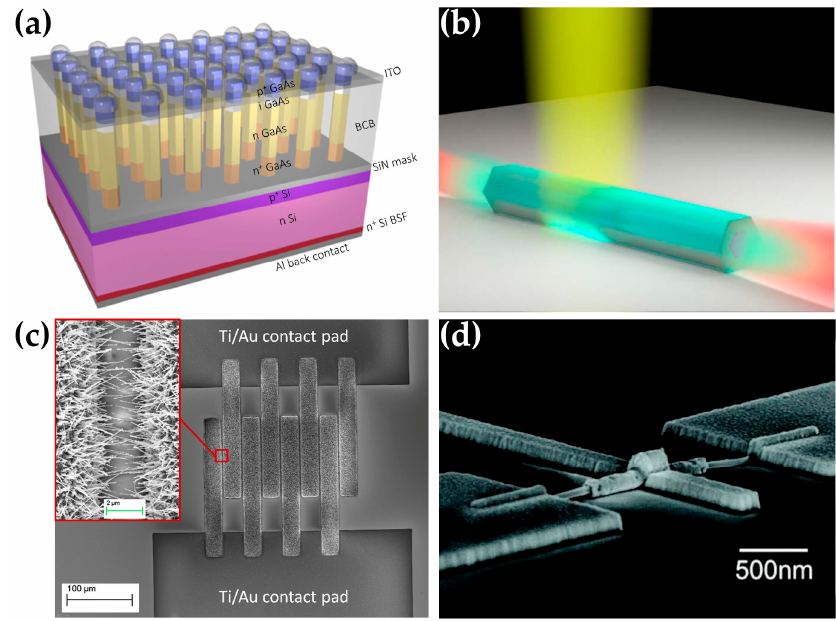
Figure 5. Different technological applications of semiconductor NWs. ( a ) Schematic of a GaAs NW- based solar cell. Reprinted (adapted) with permission from Ref. [135]. Copyright (2015) American Chemical Society. ( b ) GaAs/InGaAs NW laser concept. Reproduced from the publication of Yi et al. [136] with no modification under Creative Commons 4.0 license (https://creativecommons.org/li- censes/by/4.0/, accessed on 1 December 2022). ( c ) CuO NWs gas sensor. Reprinted from Ref. [137], Copyright (2013), with permission from Elsevier. ( d ) SEM image of an InAs FET. Reprinted (adapted) with permission from Ref. [138]. Copyright (2012) American Chemical Society.